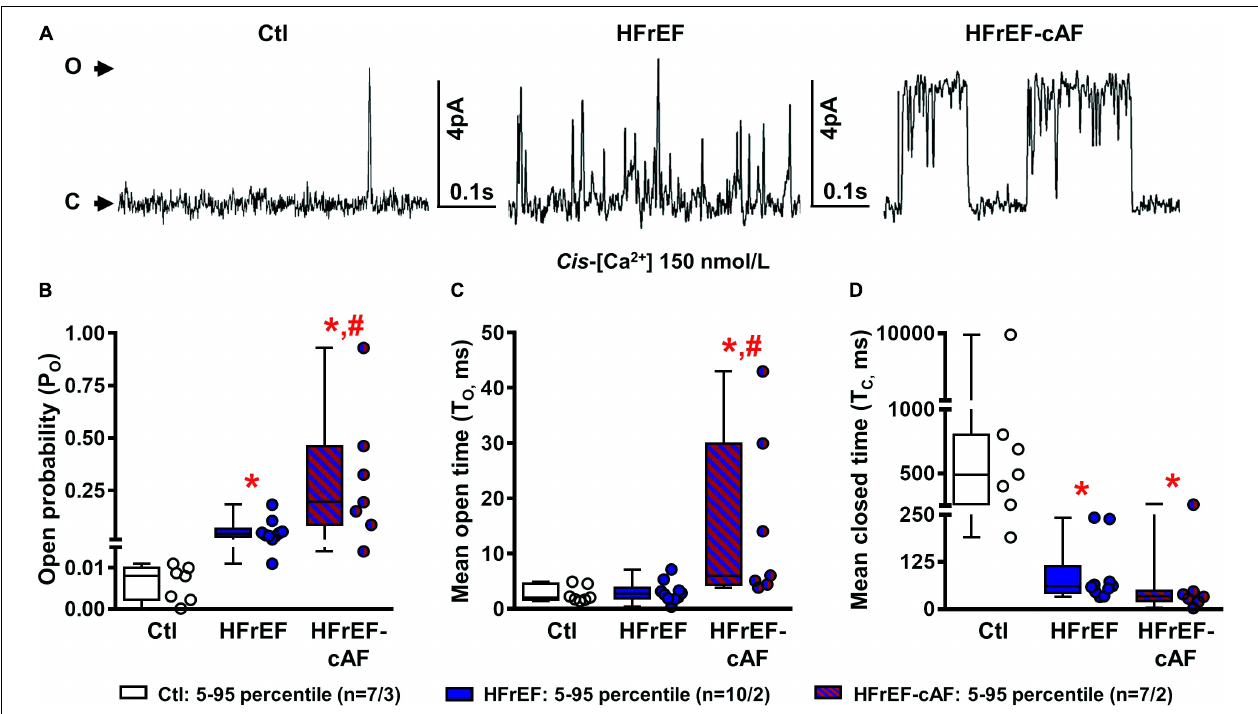
FIGURE 7 | Single-channel recordings of cardiac ryanodine receptor type-2 (RyR2) channels. (A) Representative RyR2 single-channel recording in a right-atrial sample from a Ctl, HFrEF or HFrEF-cAF patient. Upward deflections reflect channel opening. (B–D) Quantification of open probability (B) , mean open time (C) , and mean closed time (D) of single RyR2 channels from Ctl (white bars/symbols), HFrEF (blue bars/symbols) or HFrEF-cAF (red/blue-striped bars/symbols) patients. Numbers represent number of channels/number of patients. ∗ indicates P < 0.05 vs. Ctl, # indicates P < 0.05 vs.